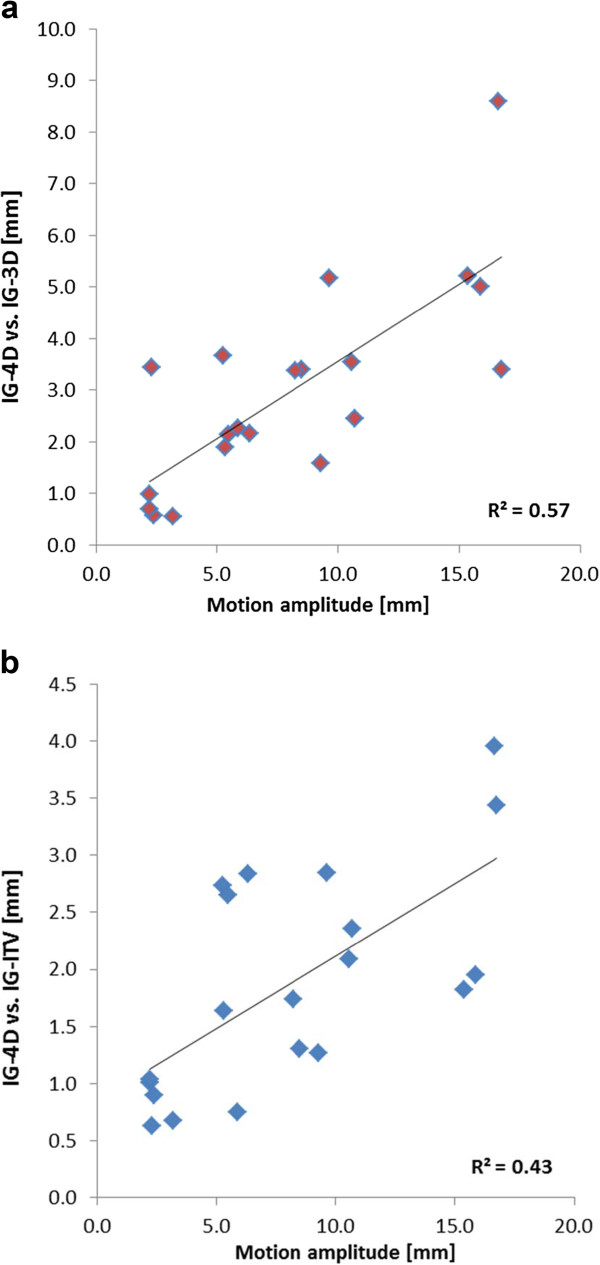
Correlation between the motion magnitude of the pulmonary target and differences between the image-guidance techniques using 4D-CBCT (IG-4D) and 3D-CBCT (IG-ITV and IG-3D).